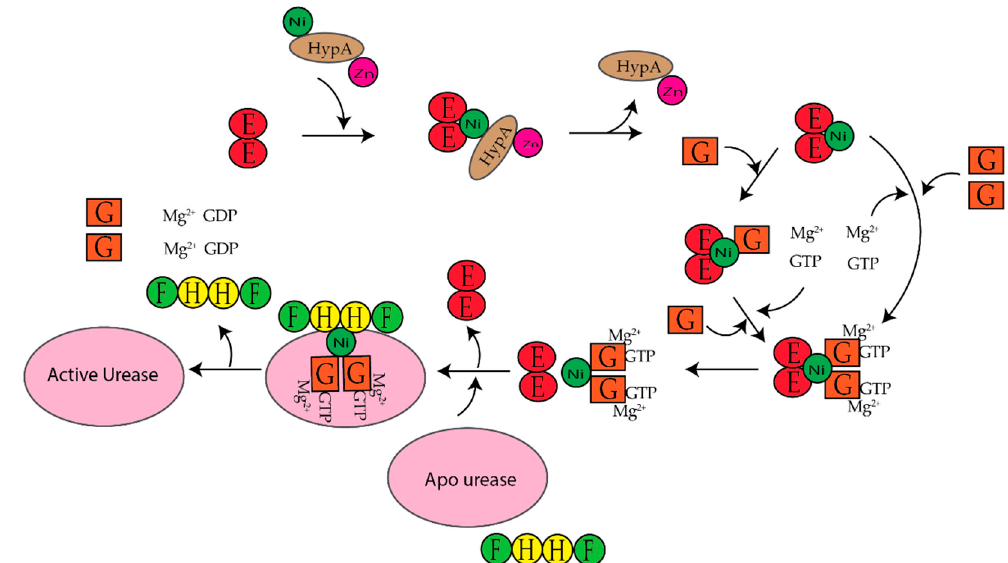
Figure 14. Model of the protein complexes required for the insertion of nickel into H. pylori urease [103,160,161]. NiZnHypA forms a complex with UreE 2 and transfers nickel to UreE 2 . NiUreE 2 will form a NiUreE 2 –UreG 2 complex either with UreG 2 or with 2 UreG in the presence of magnesium ions and GTP. A NiUreE 2 –UreG 2 complex with magnesium ions, GTP and UreG 2 is formed and nickel is transformed from UreE 2 to UreG 2 . UreG 2 forms a complex with UreF–UreH and apo urease. GTP is hydrolyzed by UreG and nickel is inserted into apo urease in the presence of potassium bicarbonate (not shown) and ammonium bicarbonate (not shown). UreF, UreH, and UreG dissociate from the Ni-urease enzyme.